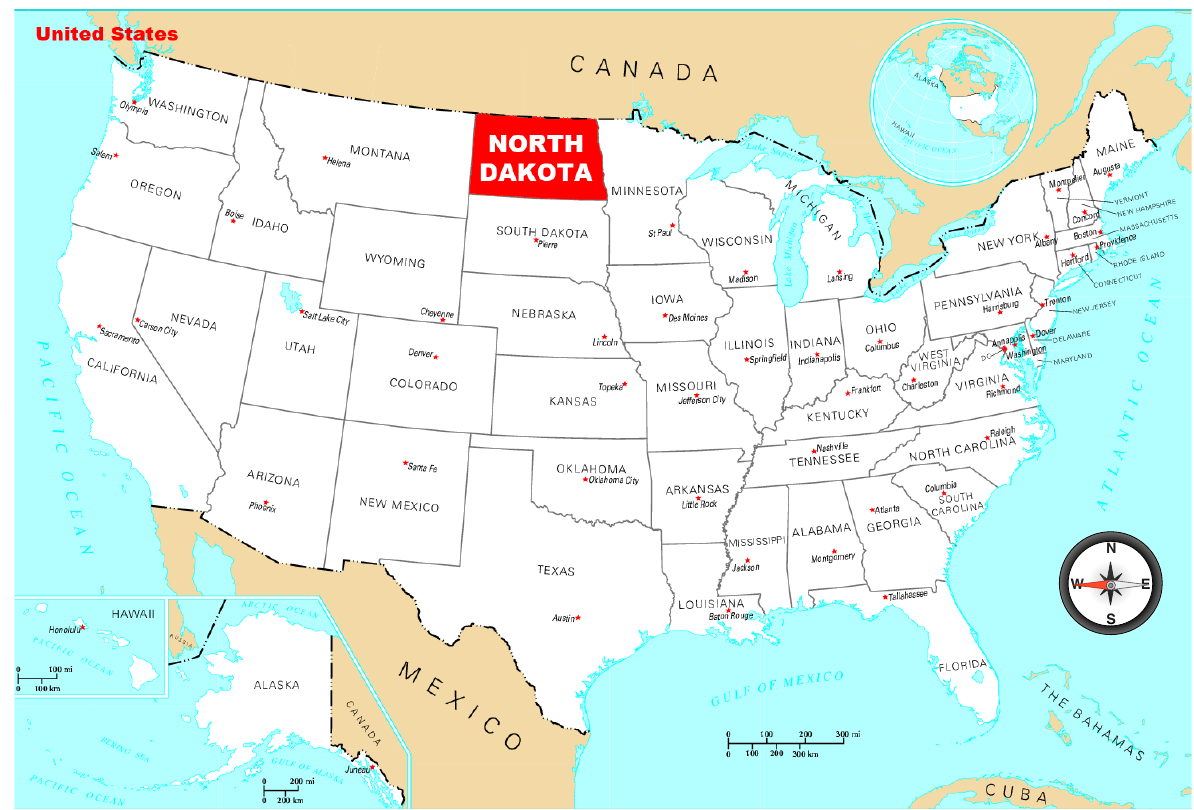
Figure 1. Location map of North Dakota in the United States